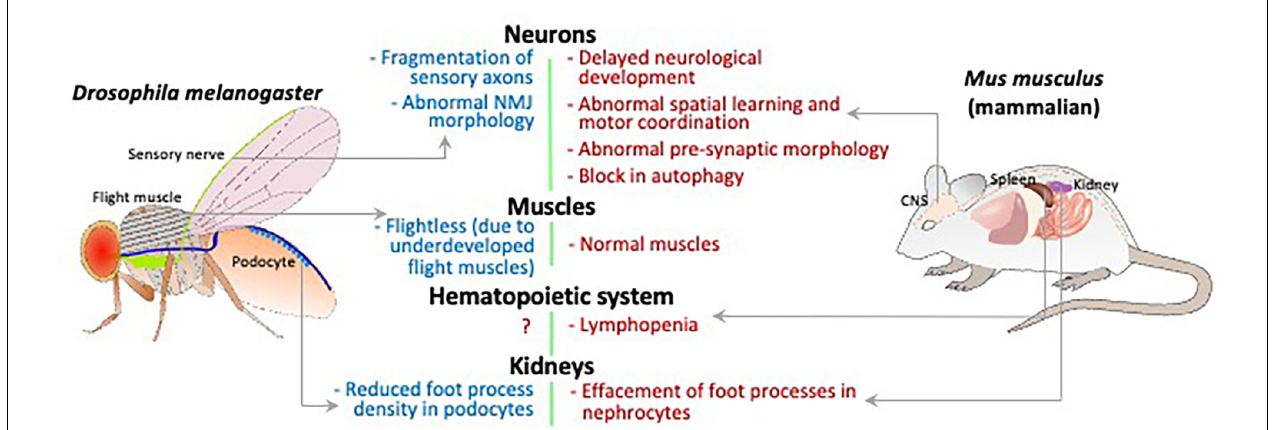
FIGURE 2 | Schematic comparing the Drosophila and mammalian organ systems for phenotypes caused by loss of S1P lyase activity. The relevant organs/tissue are labeled and phenotypes indicated with gray